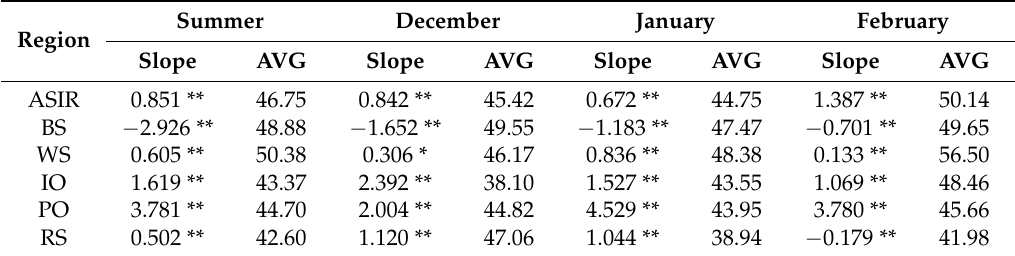
Table 3. Slope values (% per decade) and averages (%) (AVG) of the SAL during summer and for 3 months for the ASIR and the five longitudinal